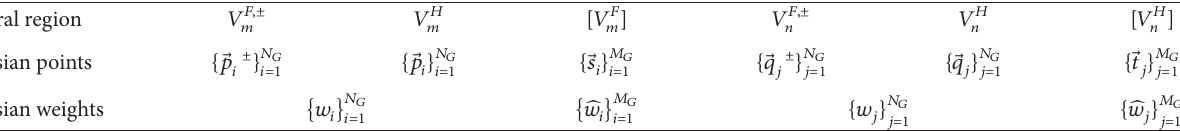
Table 1: Correspondences between integral regions and Gaussian points and weights.